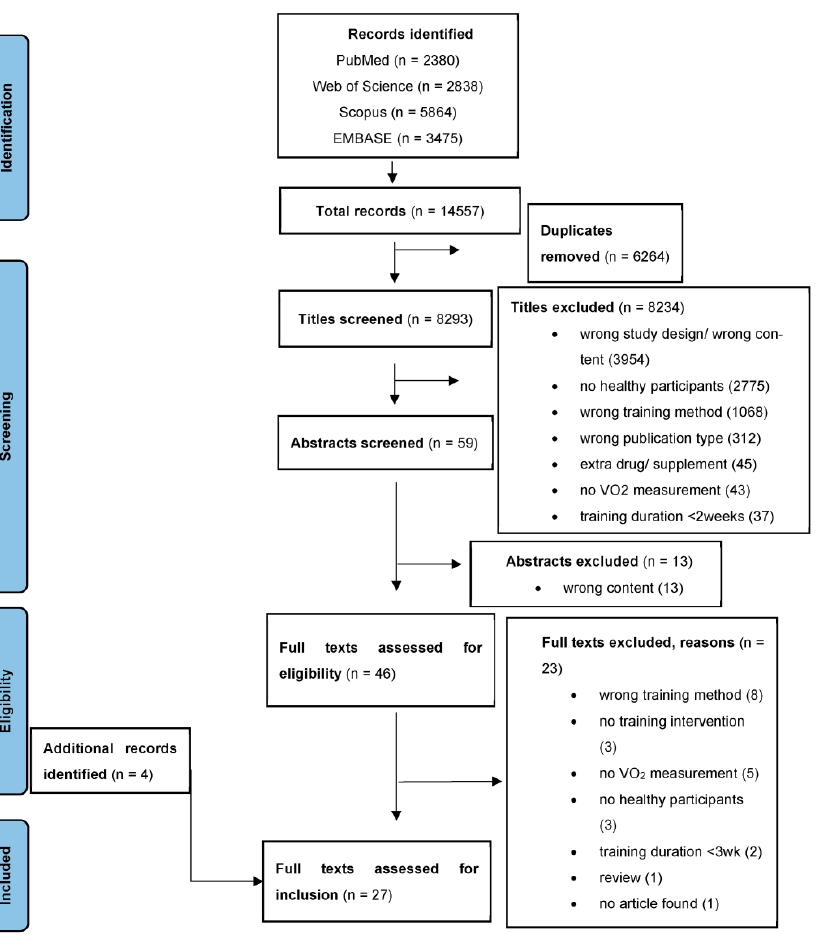
Figure 1. PRISMA flowchart of the systematic review process. PRISMA, Preferred Reporting Items for Systematic Reviews and Meta-Analyses.